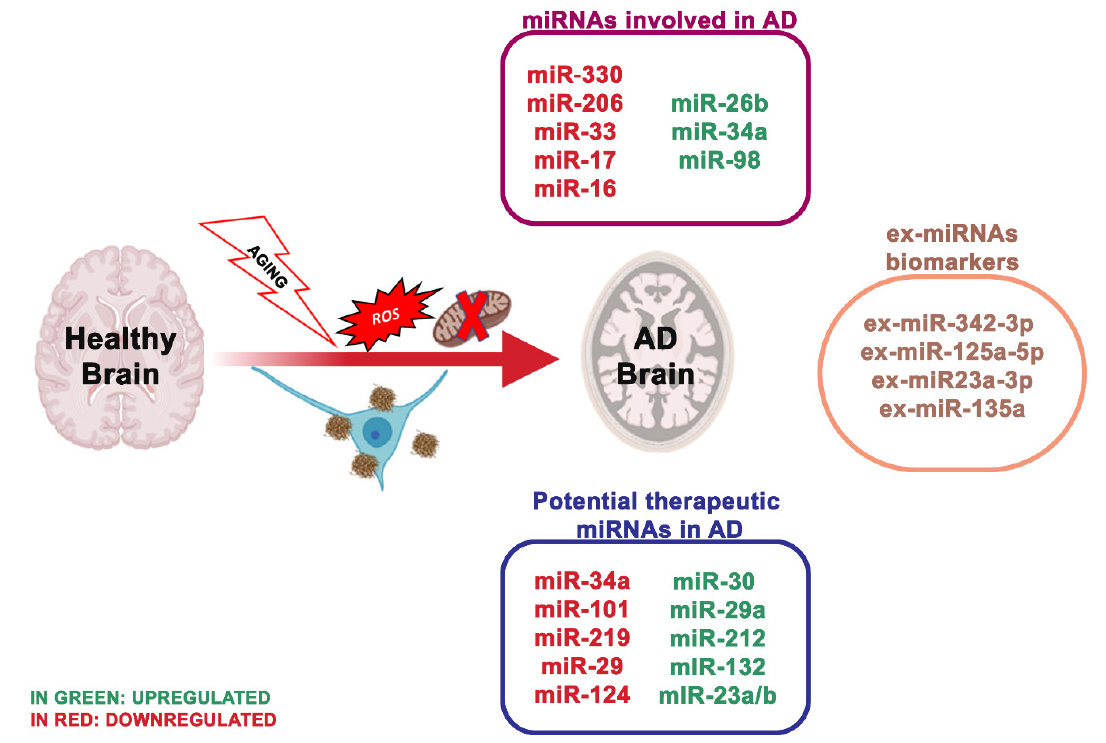
Figure 1. The most essential miRNAs involved in Alzheimer’s disease.